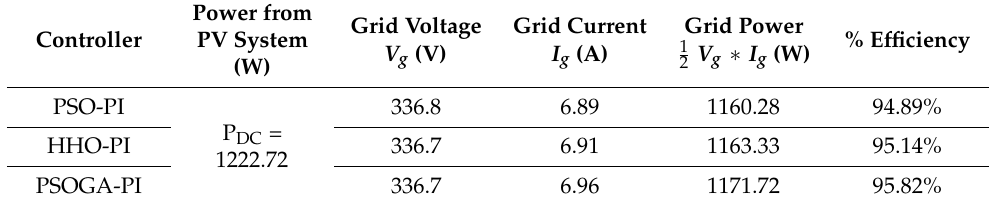
Table 7. Efficiency of the proposed GCSPV system with different